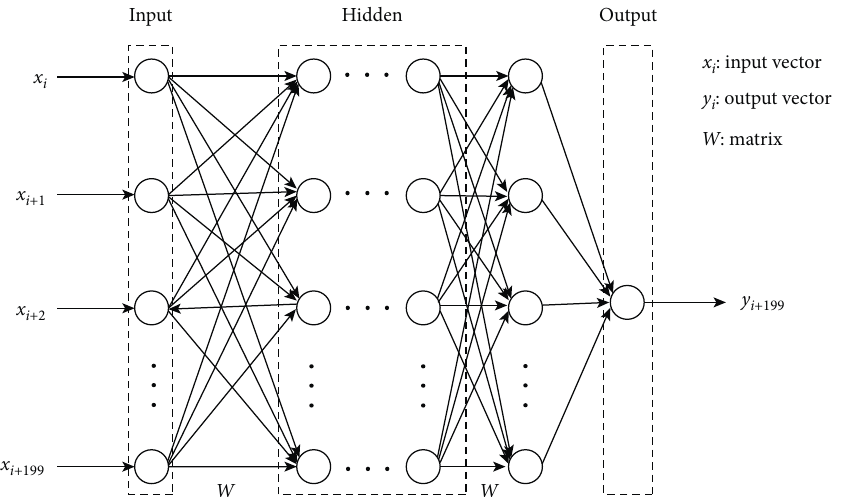
Figure 2: The structure of our ANN.